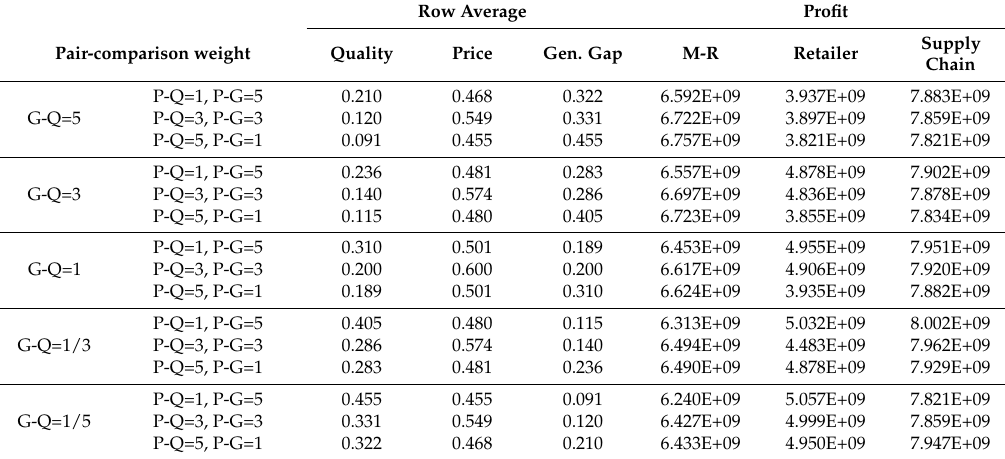
Table 8. Dataset for the analysis of customers’ expectations.